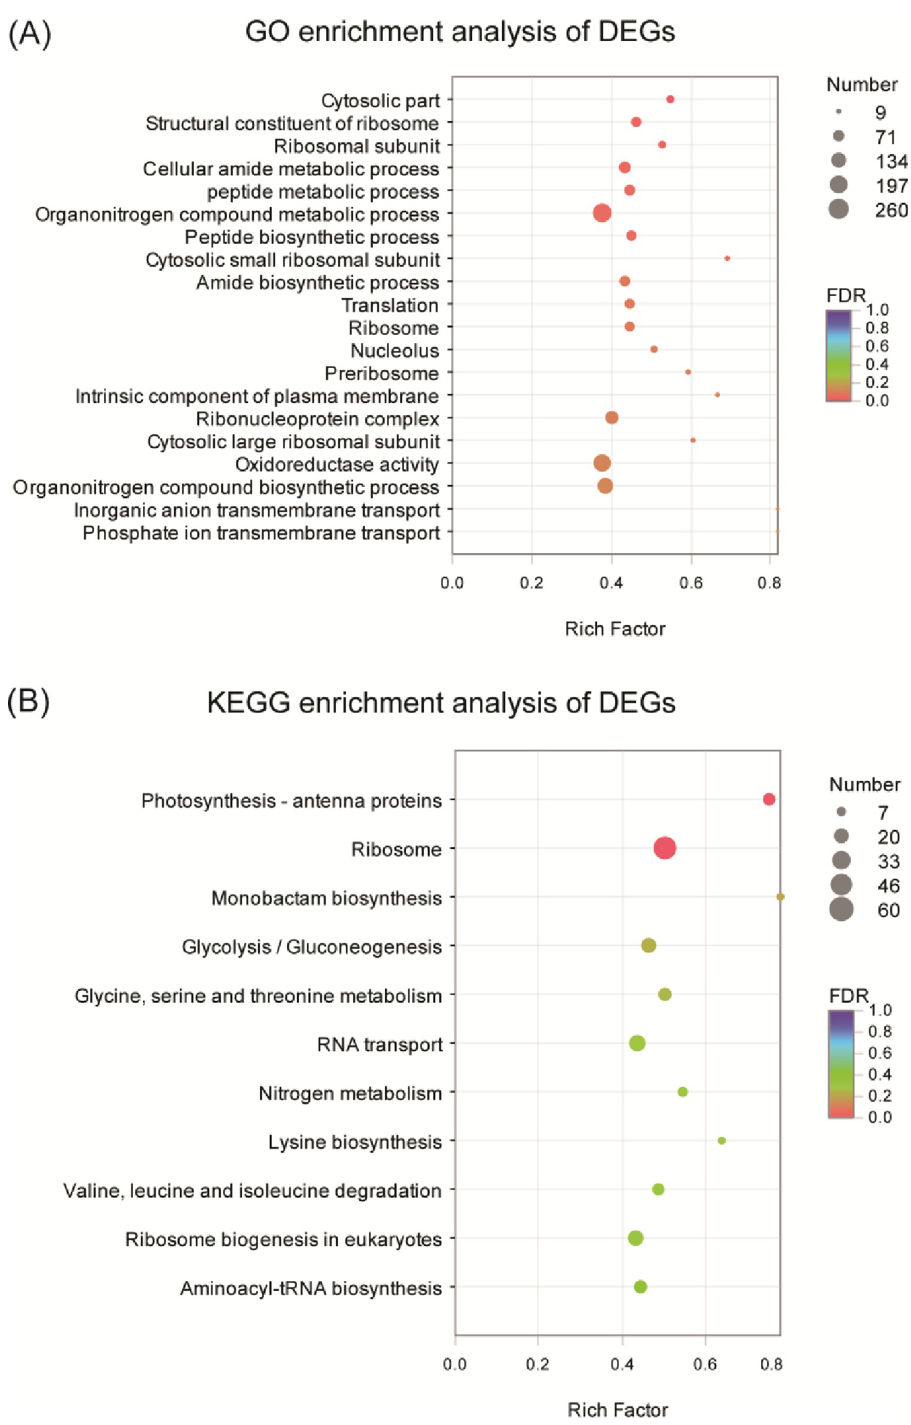
Fig 5. Functional enrichment analysis of differential expression unigenes under ND in P . cruentum . ( A ) Functional enrichment of differential expression unigenes (DEGs). By Gene ontology (GO) analysis, the DEGs were systematically classified into three subcategories, including biological process (BP), cellular component (CC), and molecular function (MF). Each bar represents the number of unigenes under each subcategory. ( B ) Enrichment analysis of differential expression genes (DEGs) by KEGG. Five main KEGG metabolism pathway categories are carbon/nitrogen and lipid metabolisms, environmental adaptation processing, genetic information processing, cellular processes, and organismal systems. Each bar represents the numbers of unigenes classified under each KEGG